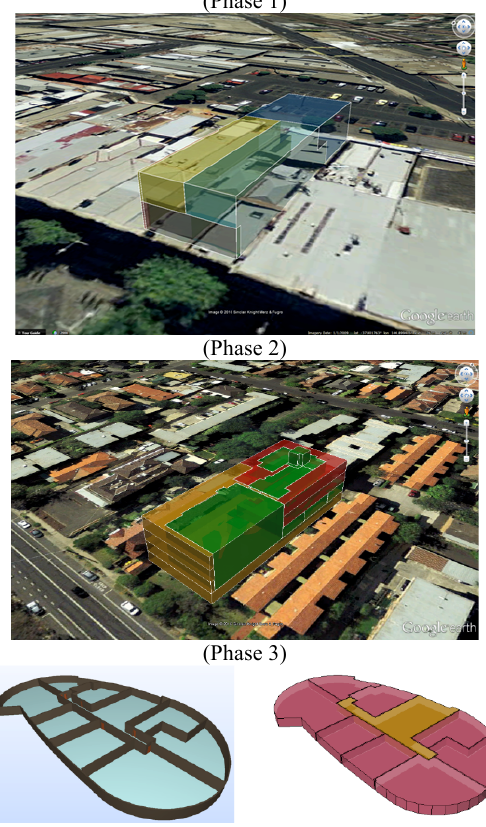
Figure 6. investigating the three phases in creating various building subdivision plans in ePlan